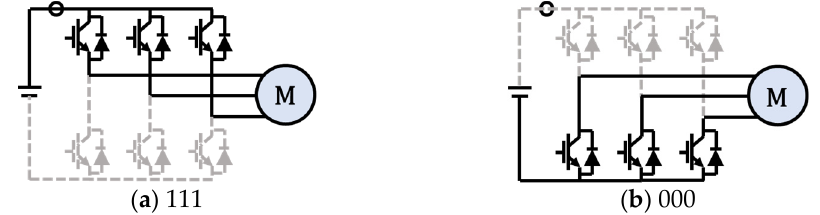
Figure 6. The current path of two zero voltage reference vectors. ( a ) S a = 1, S b = 1 and S c = 1; ( b ) S a = 0, S b = 0 and S c = 0 ;